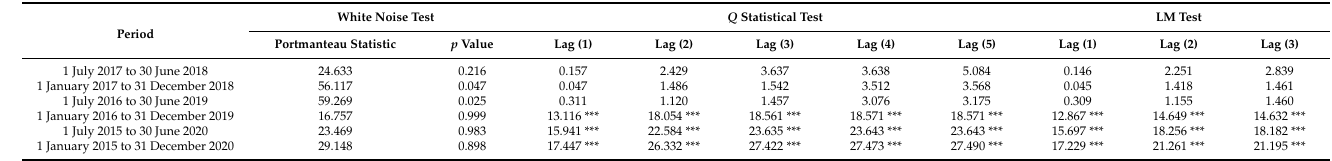
Table 3. Results of various